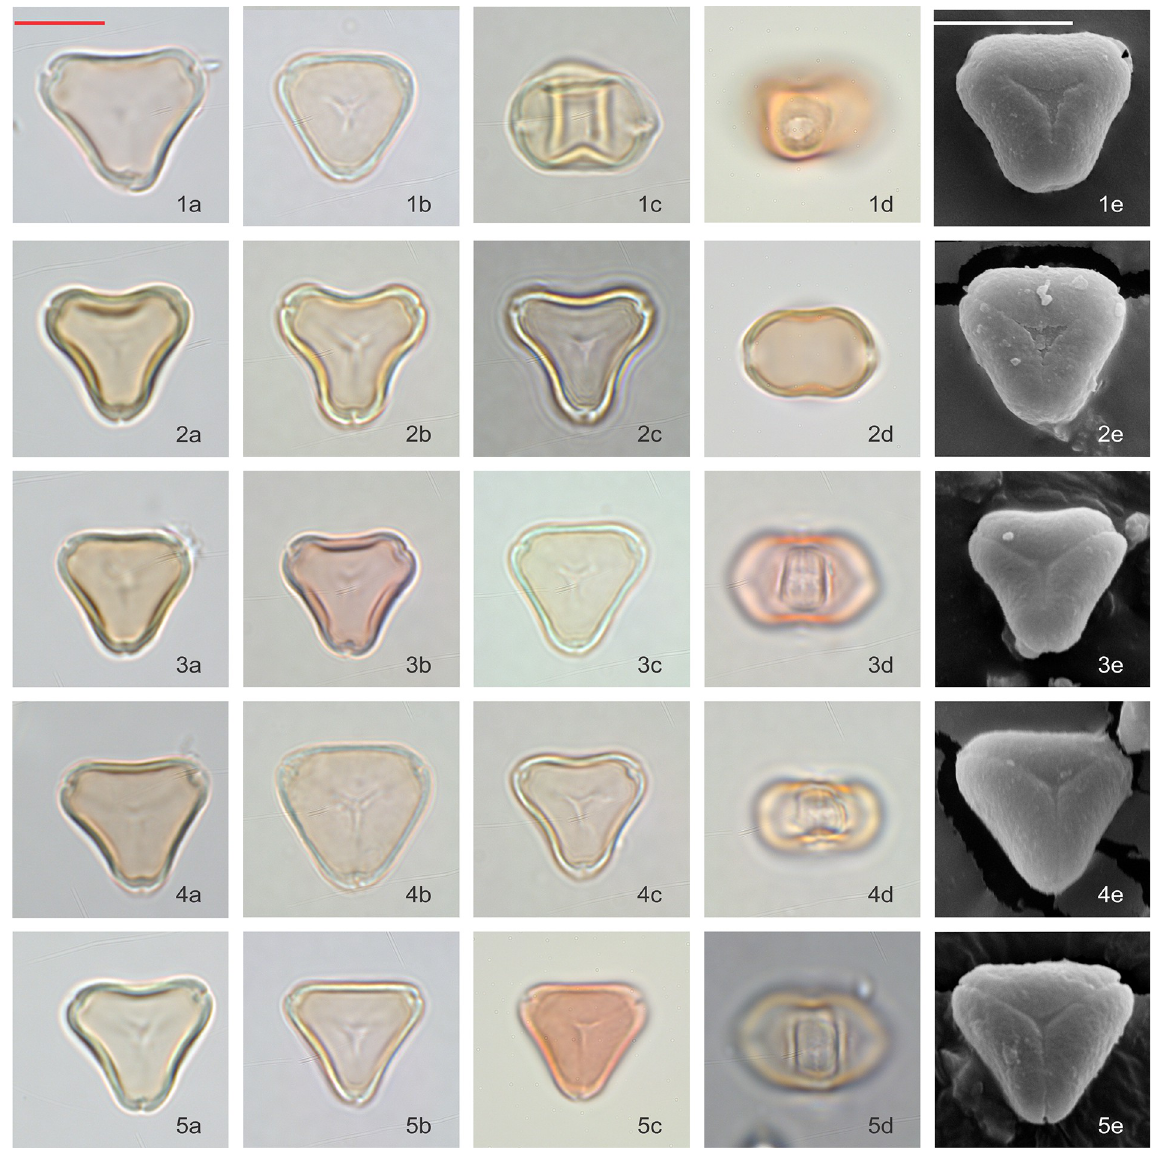
Fig 6. Polar and equatorial views of Kunzea , Part 1. Scale bar = 10 μ m. (1a-1e) K . toelkenii , (2a-2e) K . sinclairii , (3a-3e) K . serotina , (4a-4e) K . amathicola , (5a-5e) K . ericoides